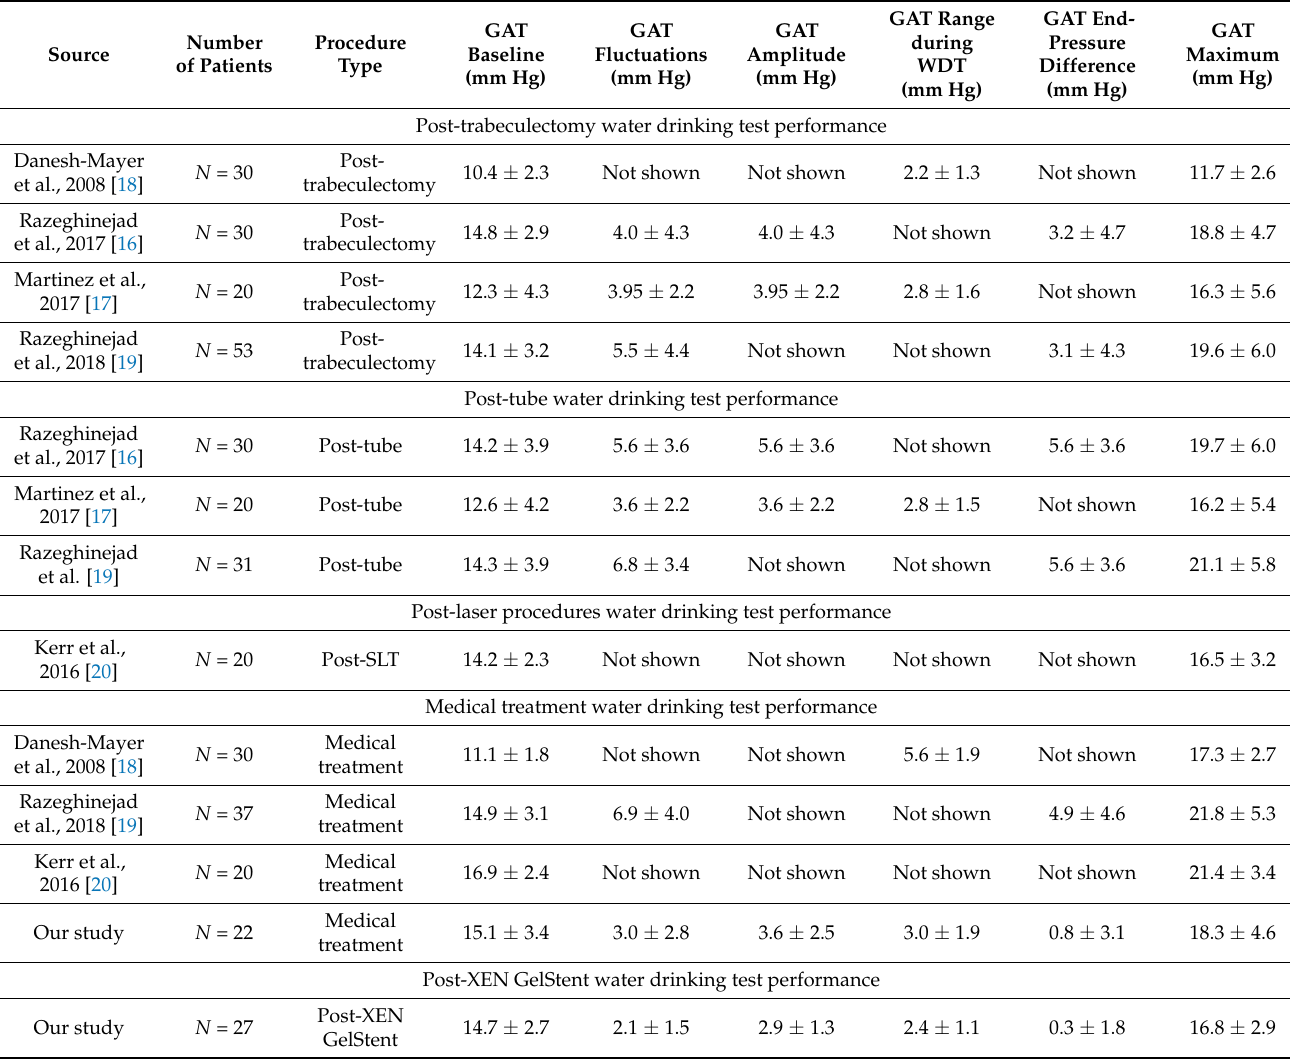
Table 4. Summary of recent studies on water drinking test after different surgical vs. medical